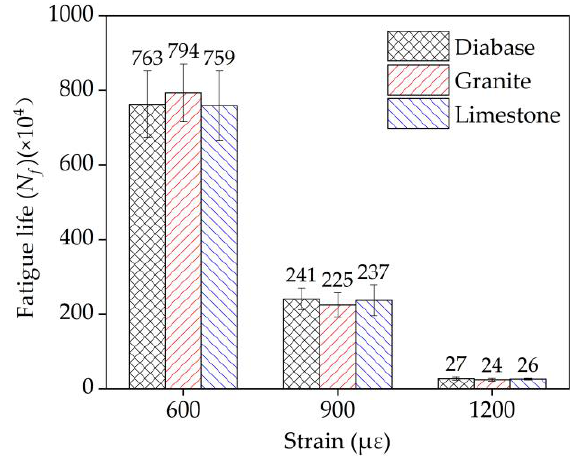
Figure 18. Fatigue test results of the three types of EACs.